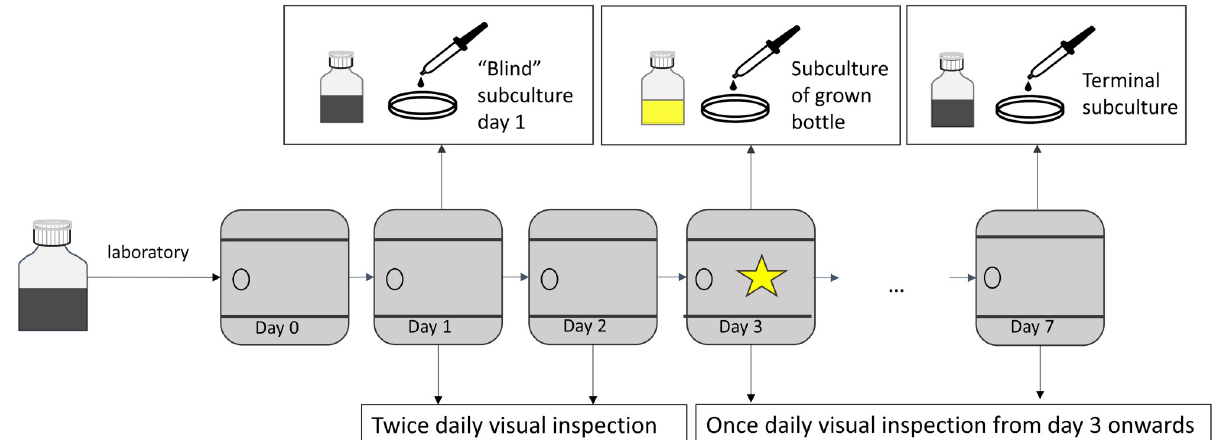
Fig 3. Laboratory processing of spiked manual blood culture bottles. The bottles are incubated on day 0. Blind subculture is performed on day 1, regardless of signs of growth. If blind subculture is negative, another subculture is done when growth is detected visually (in this example, day 3). If none of the subcultures shows growth, a terminal subculture is done on day 7.